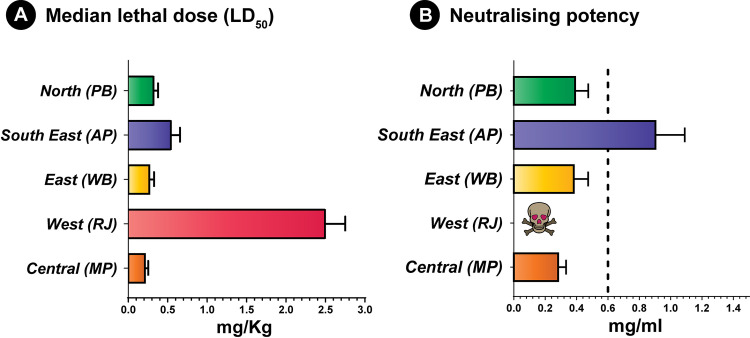
Toxicity profiles of N. naja from various biogeographic zones across India, and the neutralisation potencies of commercial Indian antivenom against these venoms.Murine intravenous median lethal doses (expressed in mg/kg) of various populations of N. naja venoms (A) and the neutralising potencies (expressed in mg/ml) of the Premium Serums commercial antivenom against these venoms (B). The vertical dotted lines in panel B indicate the marketed neutralising potency (0.60 mg/ml) of commercial antivenoms against the N. naja venom.